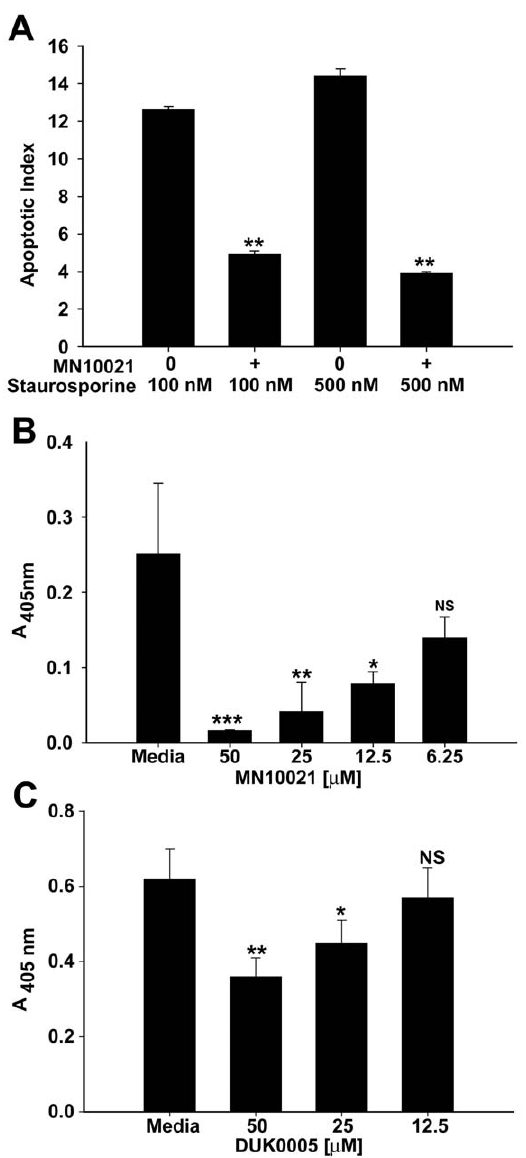
Figure 10. MN10021 and DUK0005 inhibit apoptosis and necrosis in HUVEC. A. HUVEC were grown to confluence in 96-well tissue culture plates. Media was removed from the wells and to each of quadruplicate wells was added 200 m l of either fresh media (untreated) or fresh media containing 50 m M MN10021 (treated) and the cells incubated 3 h at 37 u C. To quadruplicate wells of both untreated and treated cells were added 20 m l of media or 20 m l of media containing either 100 or 500 nM staurosporine. The plates were incubated overnight at 37 u C and the cells processed for measurement of apoptosis using the Cell Death Detection assay (Roche Diagnostics) per the manufacturer’s instructions. The apoptotic index was calculated as described in Methods. B. HUVEC were grown to confluence in 96-well tissue culture plates. Media was removed from the wells and to each of quadruplicate wells was added 200 m l of either fresh media (untreated) or fresh media containing 50, 25, 12.5, or 6.25 m M MN10021 (treated) and the cells incubated 3 h at 37 u C. To quadruplicate wells of